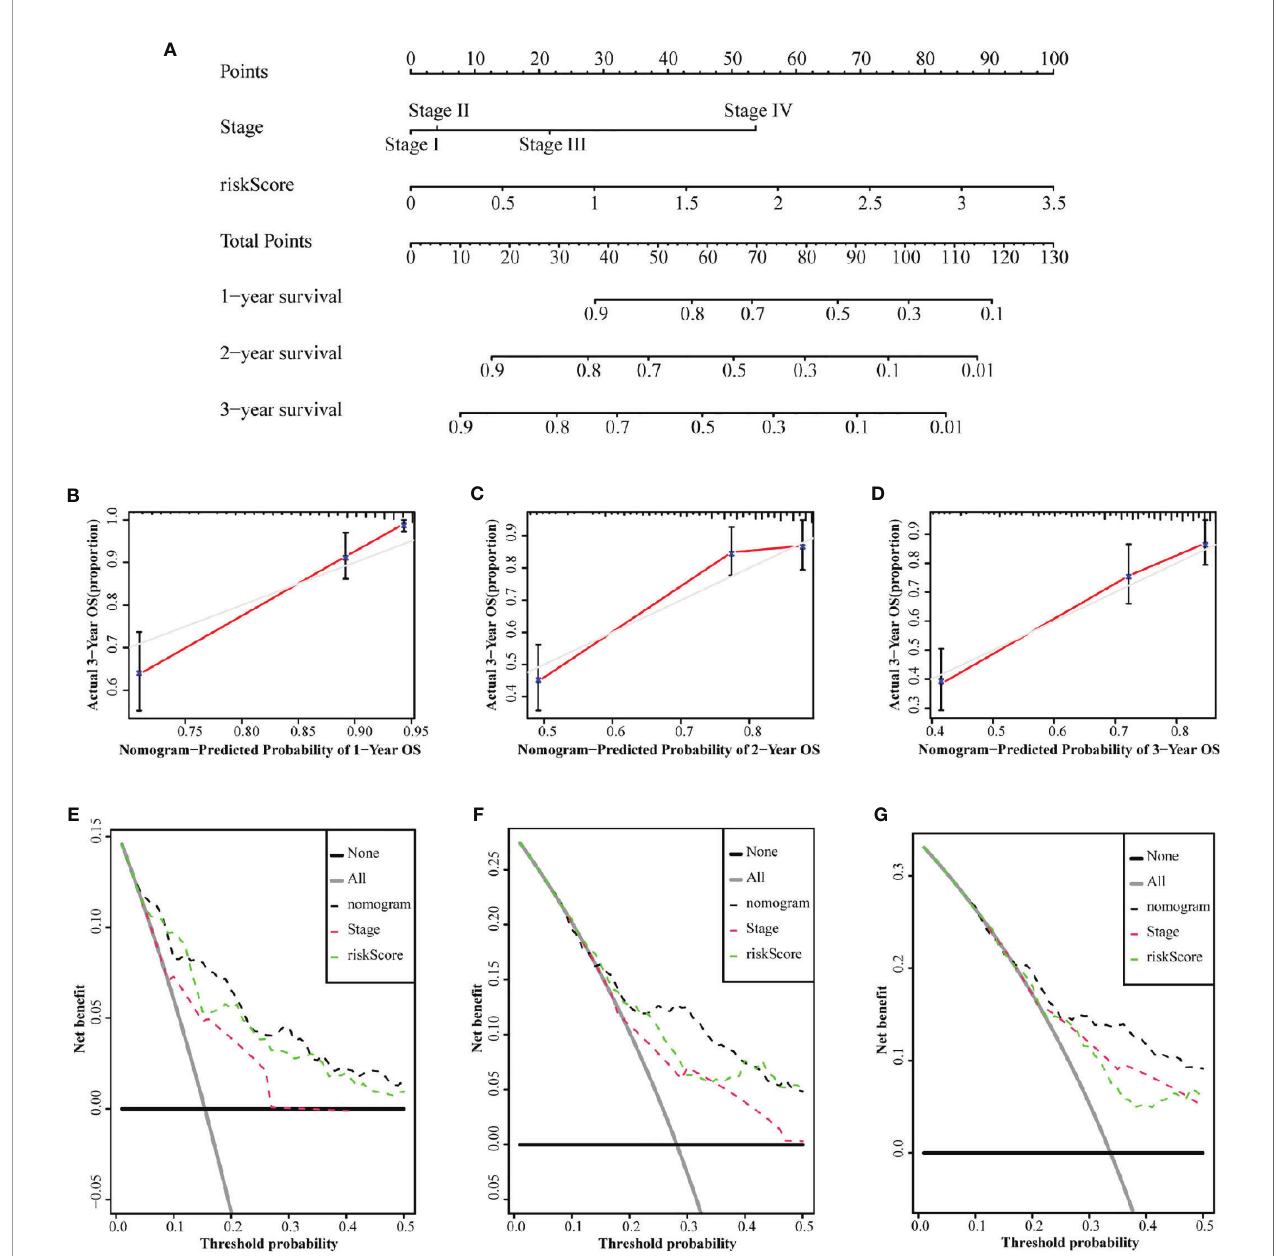
FIGURE 6 | Nomograms to predict OS in hepatocellular carcinoma patients. (A) Nomograms using clinical traits shared between the TCGA set. The calibration and DCA curve for determining the reliability of the nomogram to predict the 1-year (B, E) , 2-year (C, F) and 3-year (D, G)